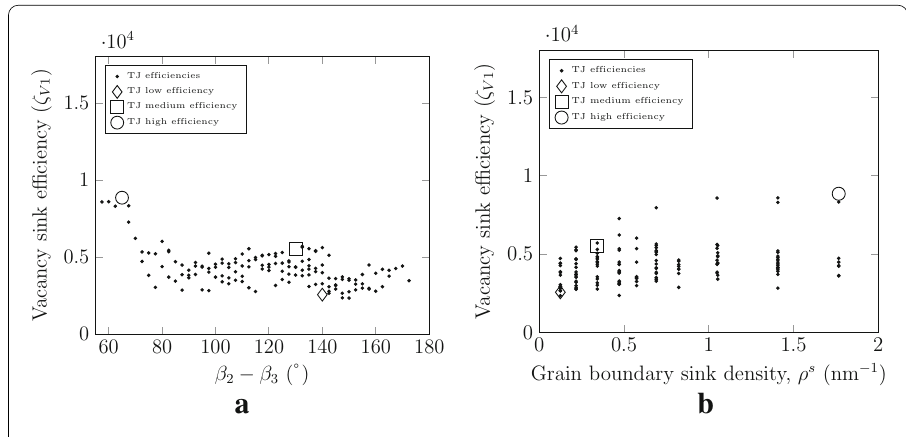
Fig. 4 Vacancy sink efficiency as a function of a the range of dihedral angles of the TJ and b GB sink density (for GB “31”). Open symbols correspond to TJ regions with low, medium and high sink